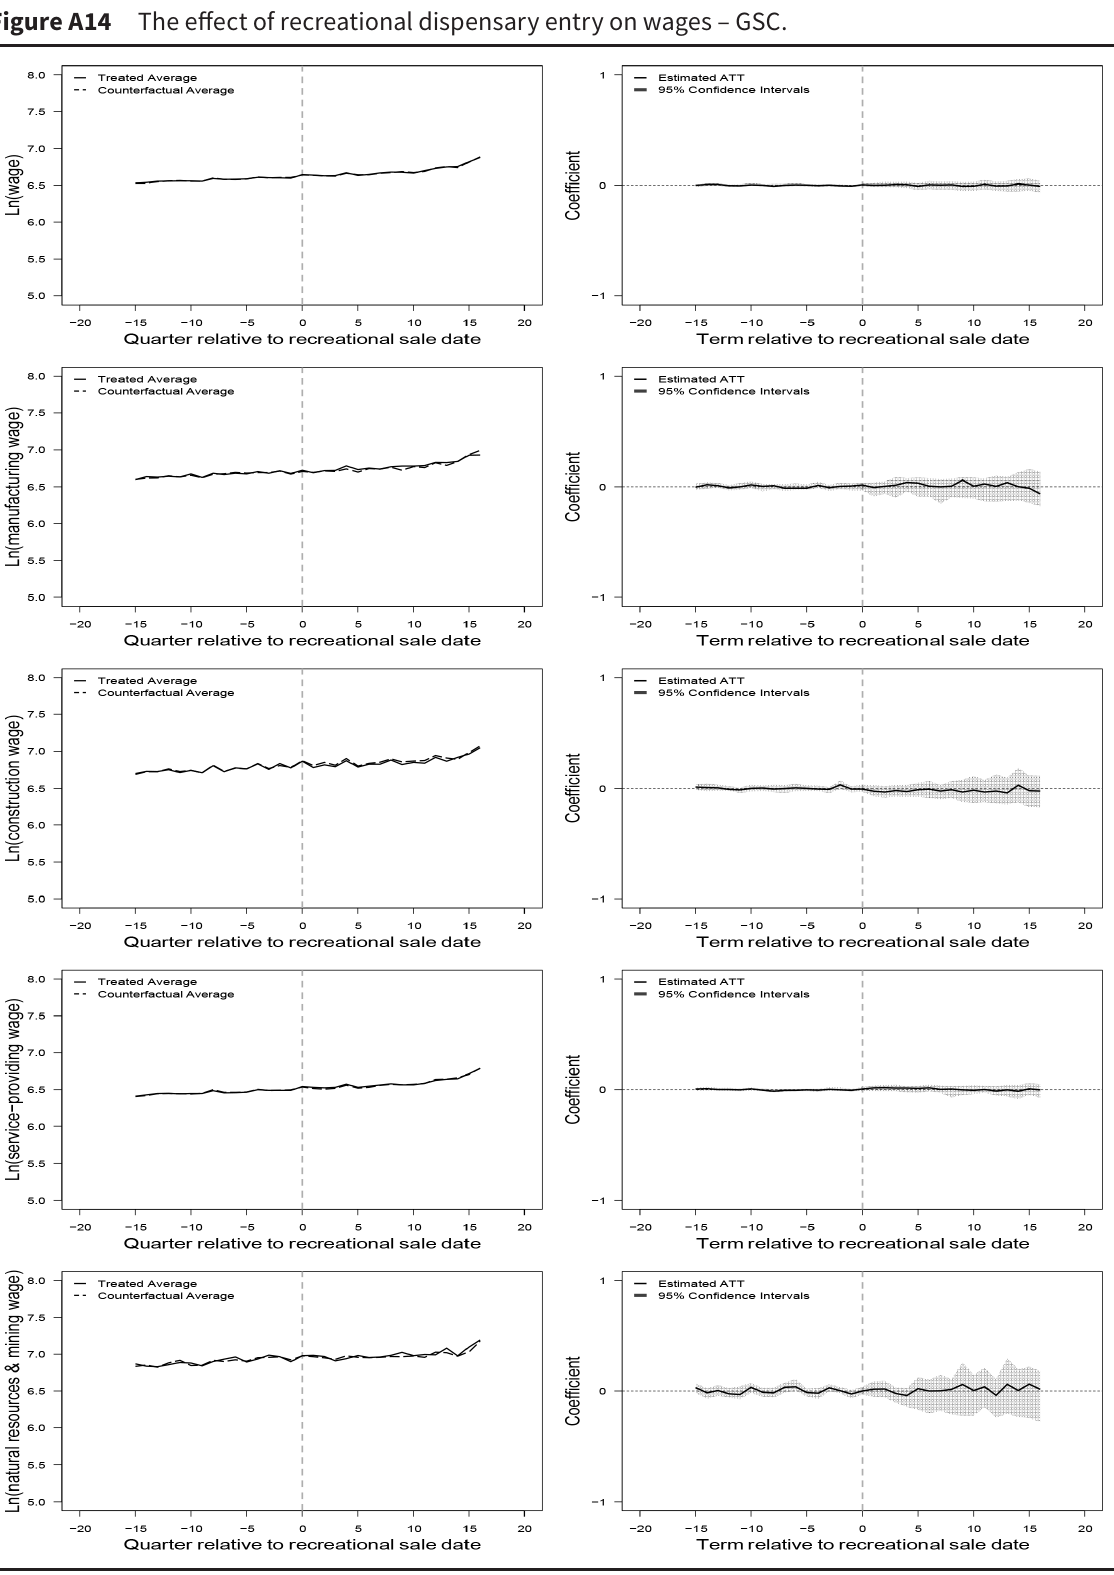
The effect of recreational dispensary entry on wages –